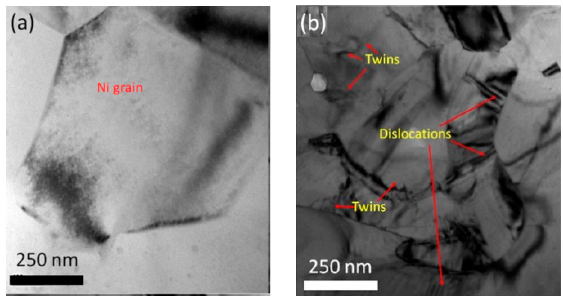
Figure 3. TEM of Ni 200 alloy: ( a ) Before MAF; ( b ) after three cycles of MAF [6]. (Reproduced with permission from Elsevier, 2018.).